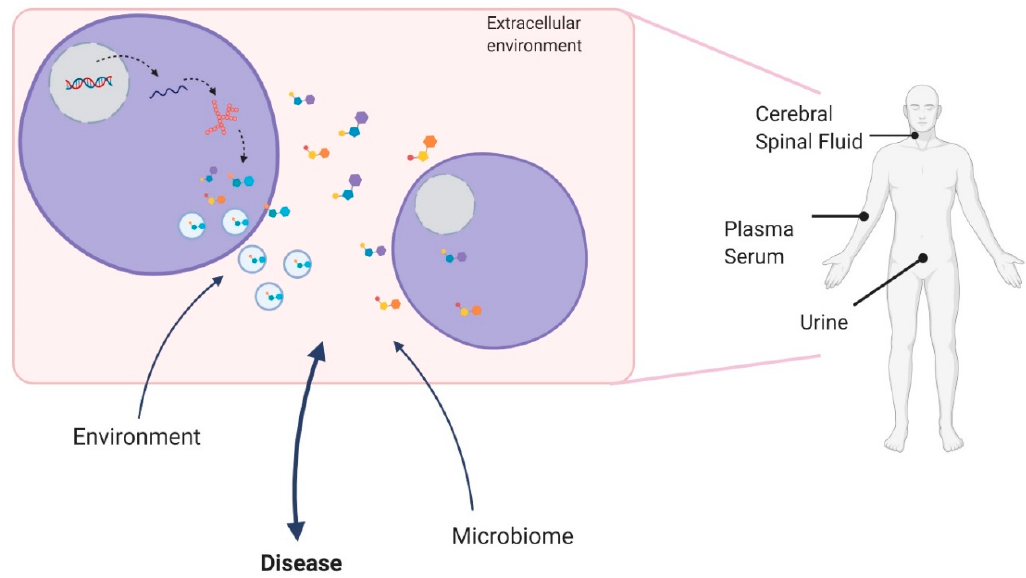
Figure 1. Circulating metabolites . Metabolites are small molecules that act locally, in the tissue where they are produced, or systemically, when released to the extracellular environment. In the latter case, metabolites can circulate and be identified in different biofluids, such as plasma serum, urine, and cerebral spinal fluid. Circulating metabolites can be released as free molecules or inside vesicles. The production of metabolites can be influenced by changes in the external or internal environment, such as the microbiome, as well as by the occurrence of disease. In this last case, the disease processes may impact metabolite production and, thus, make it possible to use metabolites as disease biomarkers. The figure was created with Biorender.com.